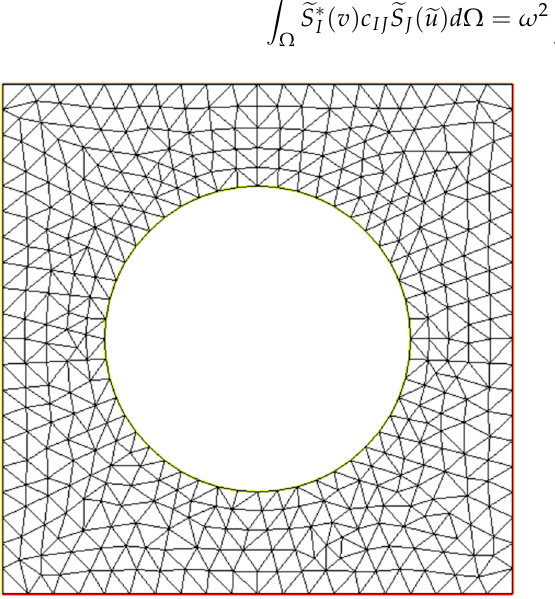
Figure 3. An example of the finite element method mesh used in calculation for a phononic crystal with d/a = 0.6 .